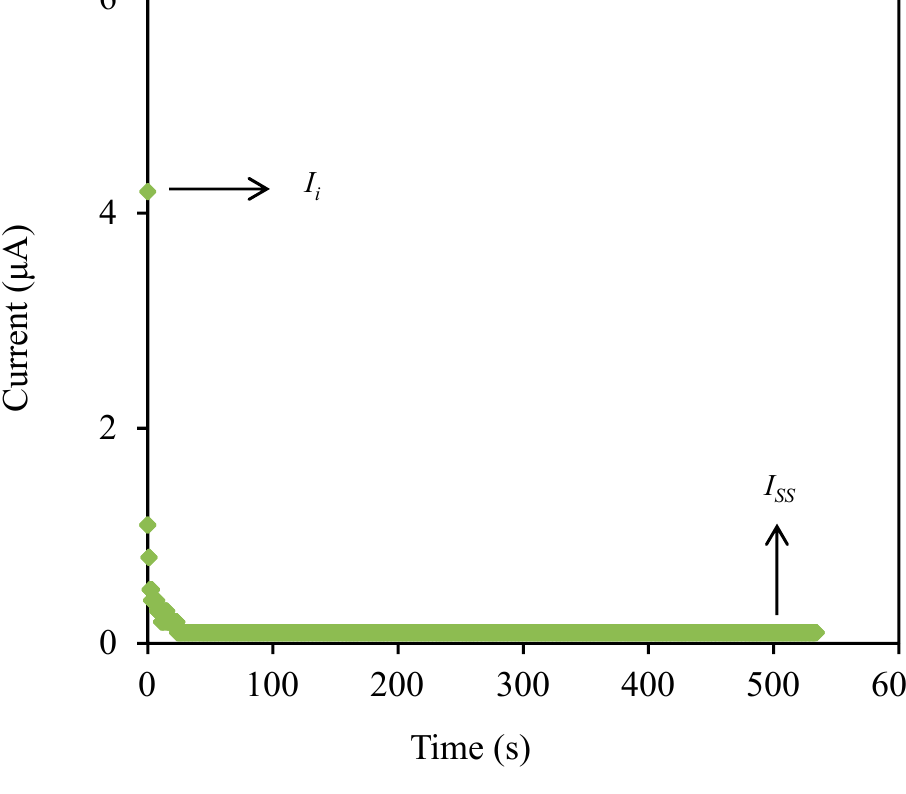
Figure 7. The polarization plot of CSMCD3 electrolyte.